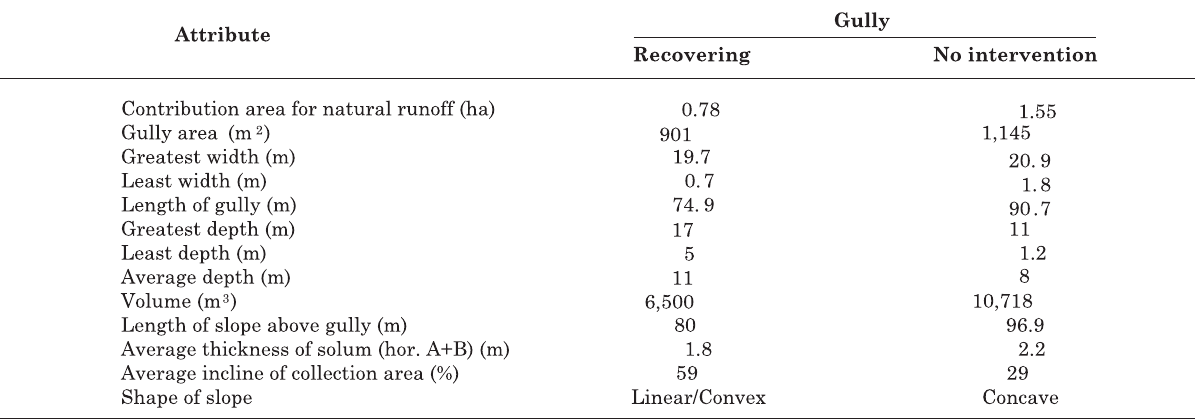
Table 2. Morphometric characteristics of slopes and